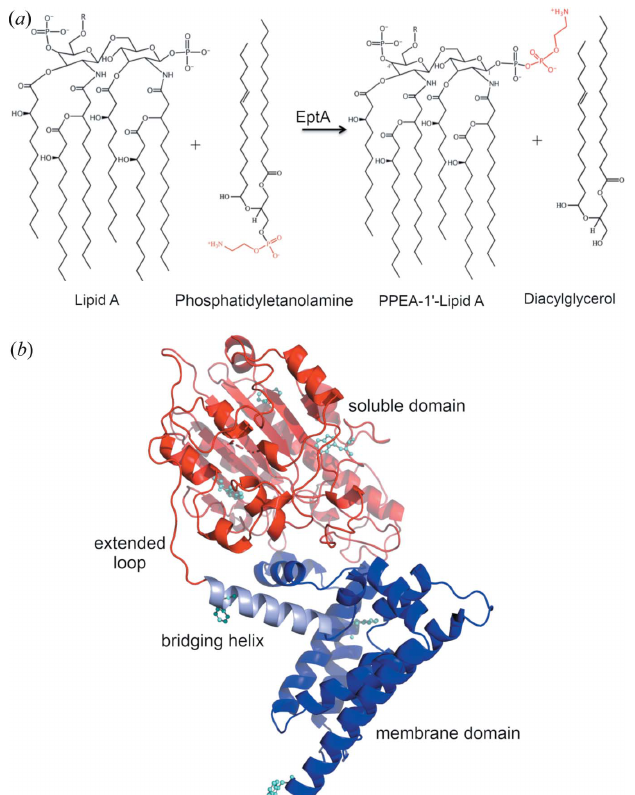
Figure 1 Catalytic reaction and structure of EptA. ( a ) Reaction catalysed by EptA. ( b ) Secondary structure representation of EptA from N. meningitidis (PDB entry 5fgn). The N-terminal transmembrane domain is represented in dark blue and the C-terminal soluble domain is represented in red. The bridging helix that connects the transmembrane domain and soluble domain is represented in pale blue. The tryptophan residues in the protein are depicted as cyan balls and